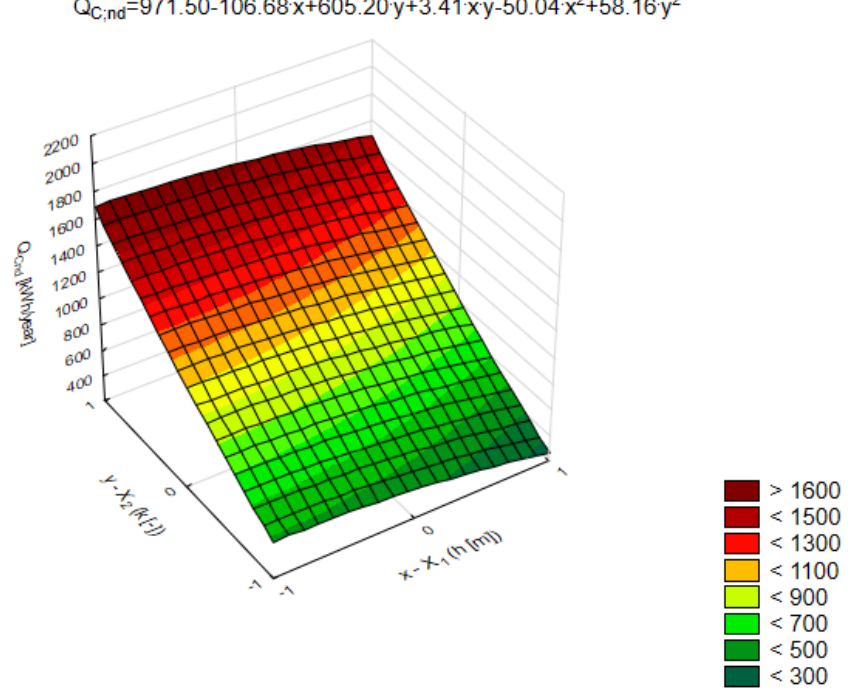
Figure 8. Dependence of Q Cnd on factors from the first group of parameters, i.e., architectural and spatial: X 1 —the height of rooms in the building h and X 2 —the window area changes coefficient k